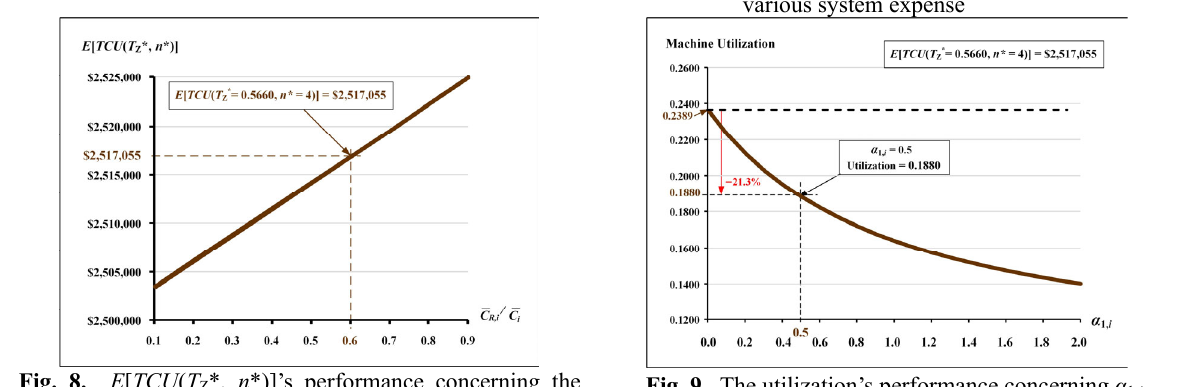
Fig. 9. The utilization’s performance concerning α 1, i